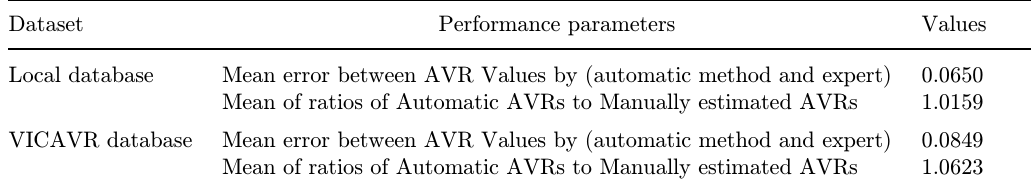
Table 9. AVR Results for local and VICAVR